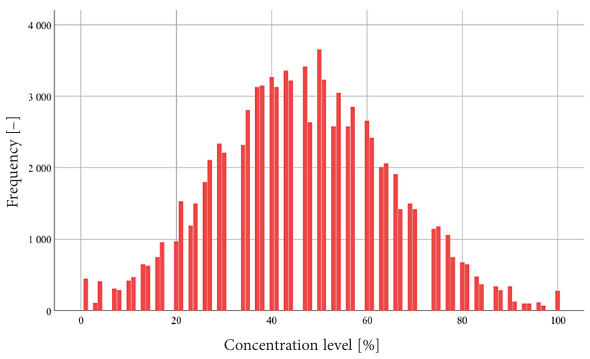
Figure 4. The distribution of the “Concentration level” variable